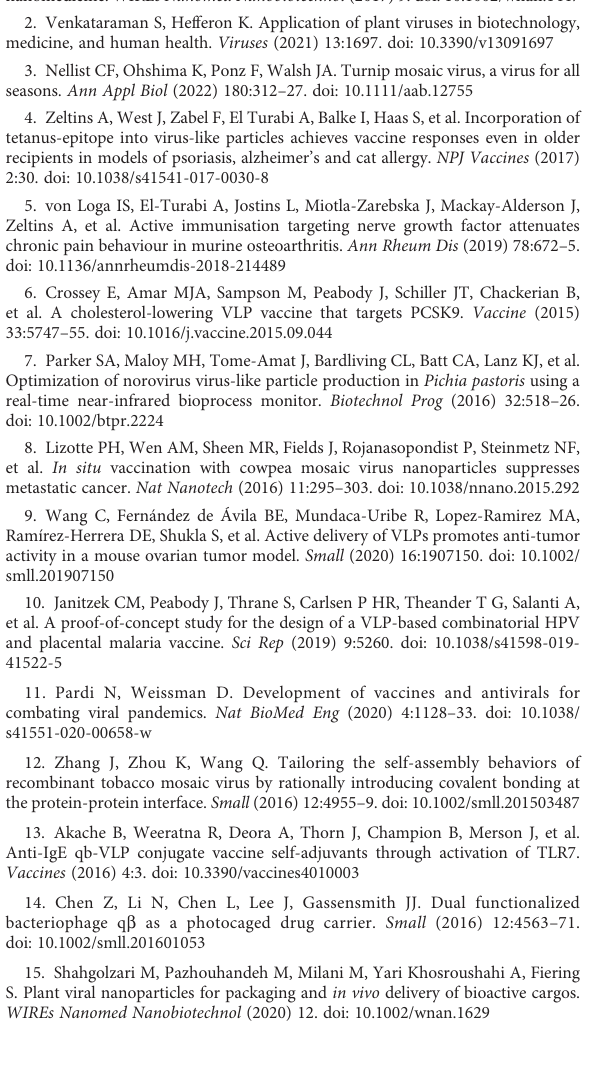
SUPPLEMENTARY FIGURE 1 Nicotiana benthamiana leaves agroin fi ltrated with the different constructs. Leaves in fi ltrated with CP or Pru p 3-LF-CP ( fl exible linker) construct show clear bleaching patches, absent or almost absent in the Pru p 3-LH-CP (helicoidal linker)